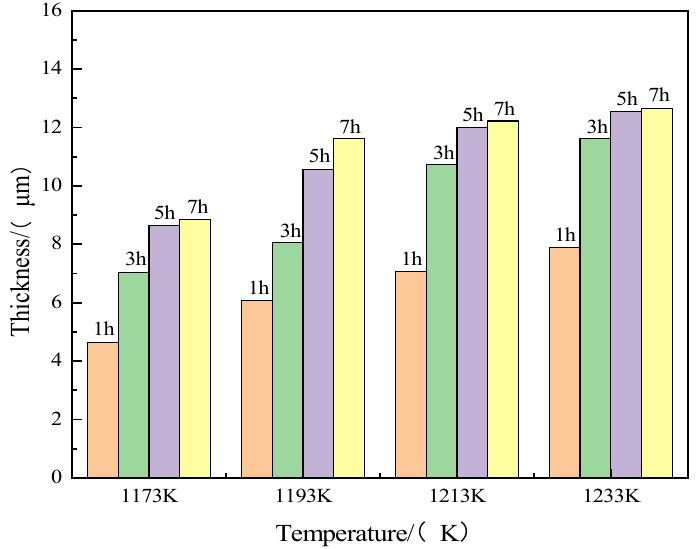
Figure 9. The thickness variation in vanadiumizing layer prepared at different heating temperatures and durations.